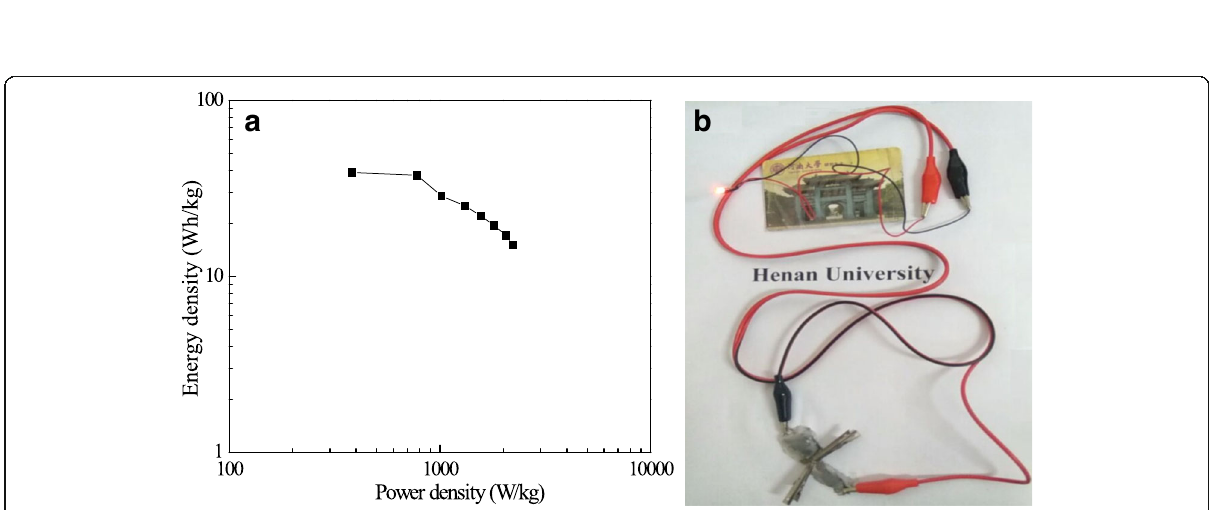
Fig. 8 The energy density of as-prepared quasi-solid-state MM//PM ASCs at different power densities ( a ). Diagram of a small red LED bulb is lighting up with as-prepared ASCs ( b